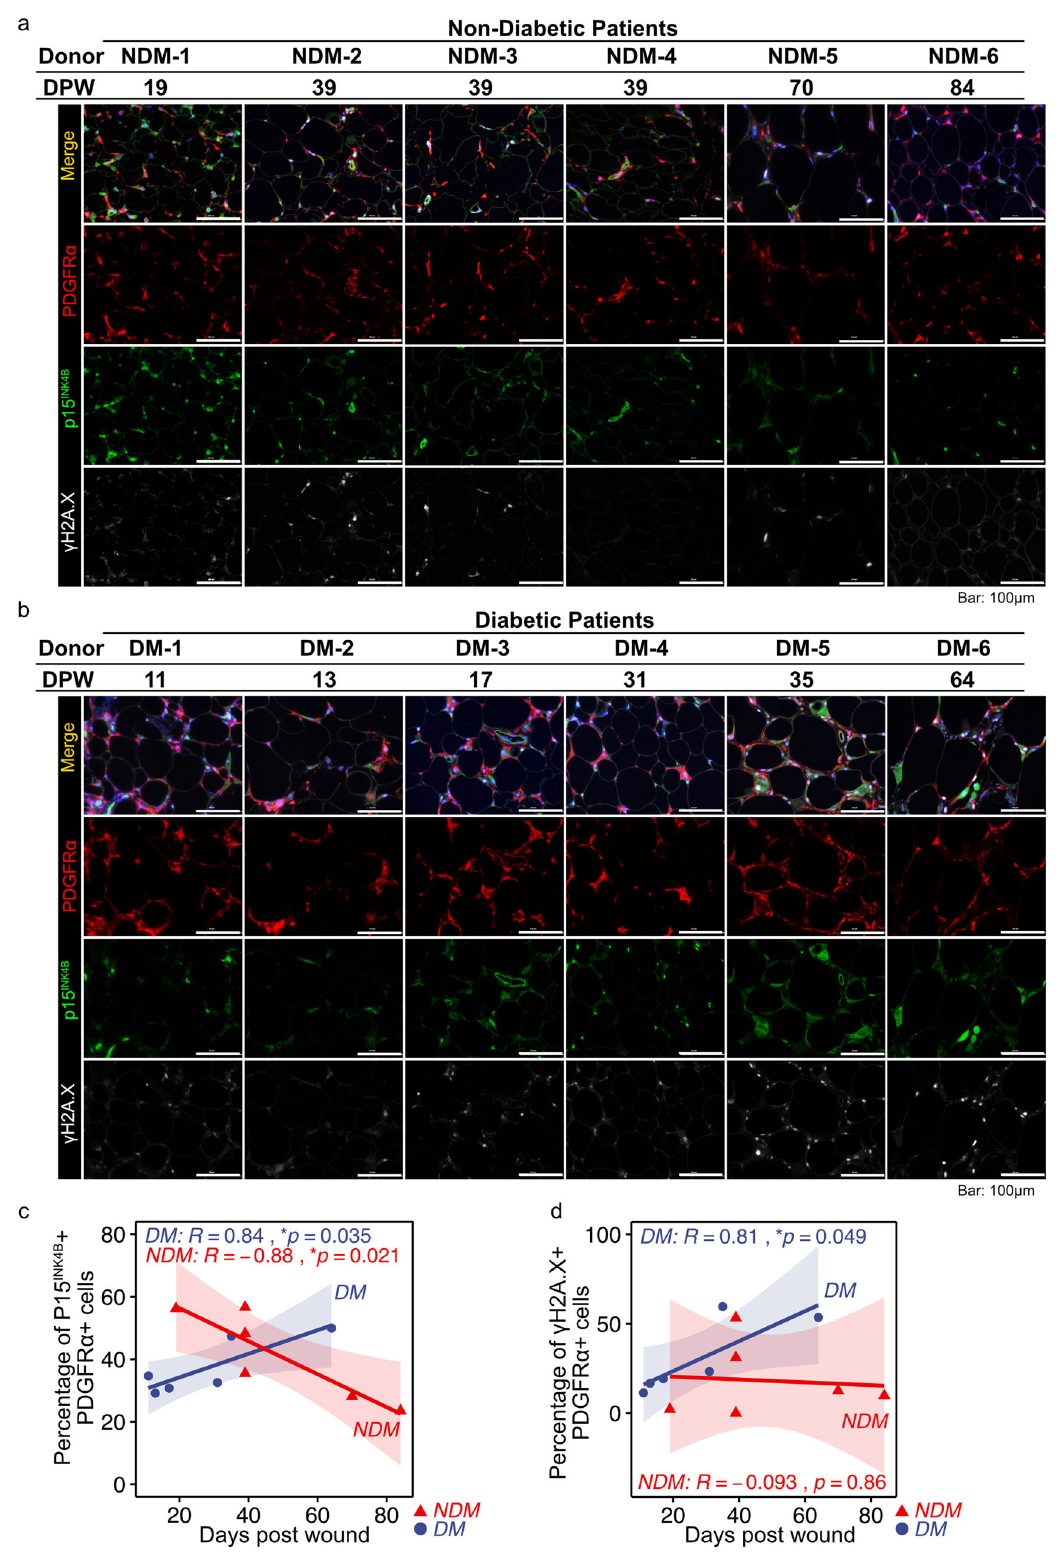
Fig. 5 Cellular senescence in subcutaneous adipose tissue during wound healing in diabetic patients. a, b Representative images of adipose tissue immunostained for PDGFR α , p15 INK4B , and γ H2A.X. during wound healing in diabetic and non-diabetic patients. c, d Correlation between the percentage of p15 INK4B + or γ H2A.X + cells in PDGFR α + cells and time post-wounding ( n = 6 for each group). Correlations were examined statistically using Pearson ’ s correlation coef fi cient, and 95% con fi dence intervals are shown with translucent fi ll corresponding to each marker color.